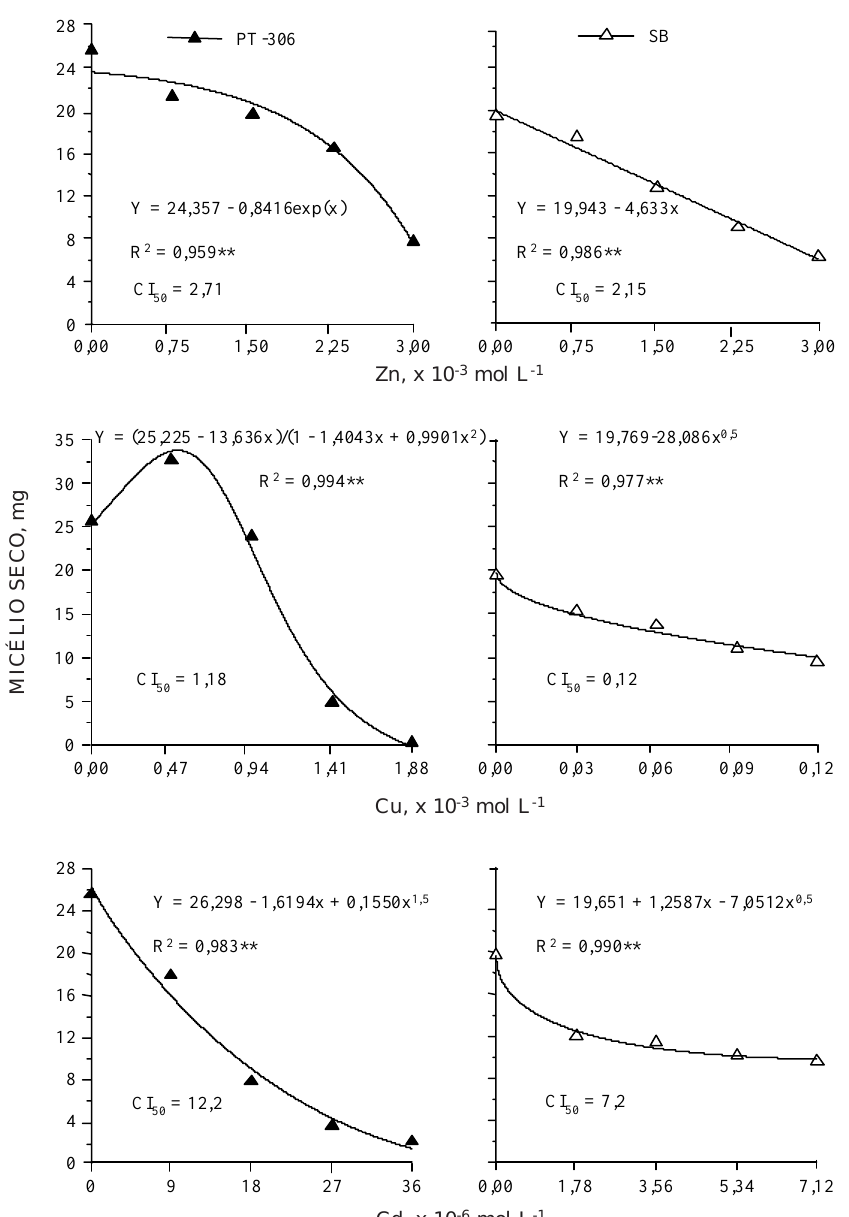
Figura 1. Crescimento dos isolados PT-306 e SB em meio MNM líquido com doses crescentes de Zn, Cu e Cd, na forma de sais. CI = concentração que inibiu 50% do 50